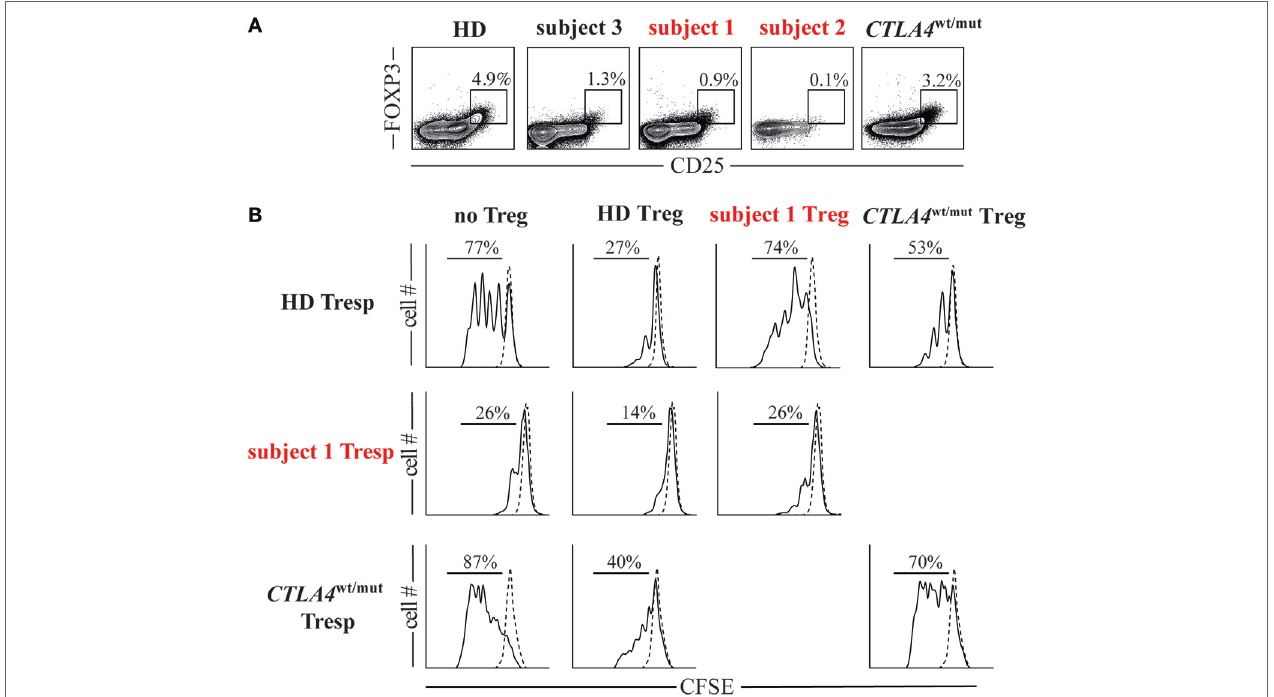
FIGURe 3 | Cytotoxic T-lymphocyte-associated protein 4 (CTLA4)/CD28 haploinsufficiency is associated with quantitative and qualitative T regulatory cell (Treg) defects. (a) Frequencies of Foxp3 + CD25 hi Tregs in subjects and a representative healthy donor (HD) are displayed. (B) Histograms display day 4 cell proliferation of unstimulated (dotted line) and anti-CD2/CD3/CD28 stimulated (black line) T responder (Tresp) cells cultured with or without autologous or heterologous CD25 hi CD127 lo Tregs in a 1:1 Tresp to Treg